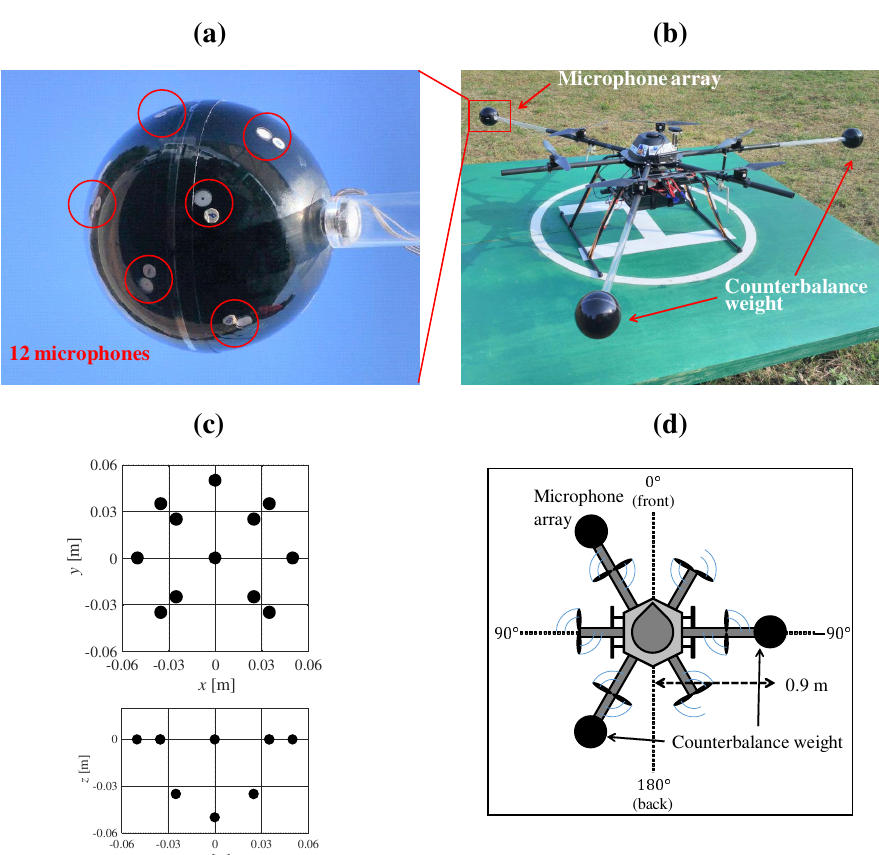
Figure 2. SMAS (spherical microphone array system). ( a ) the 12 microphones, and six of them marked as red circles; ( b ) UAV (unmanned aerial vehicles) with SMAS and two counterbalance weights; ( c ) coordinates of the microphone positions in the SMAS; ( d ) layout of the SMAS and two counterbalance weights in the UAV.